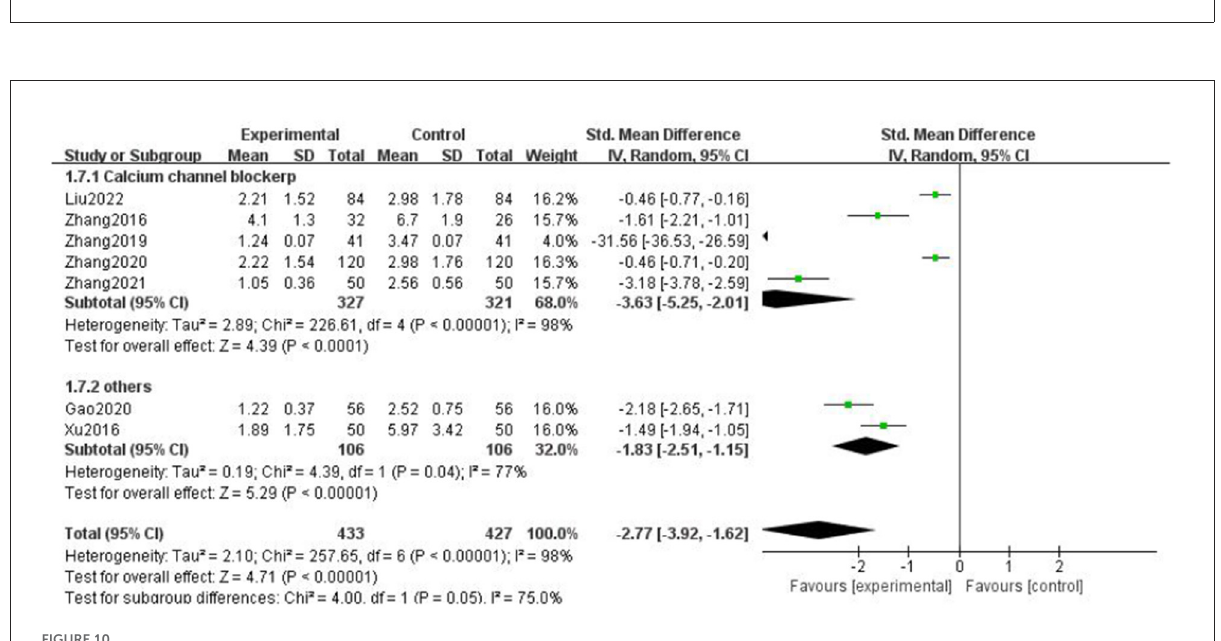
FIGURE9 Forest chart of headache duration divided into subgroups according to medication mode.